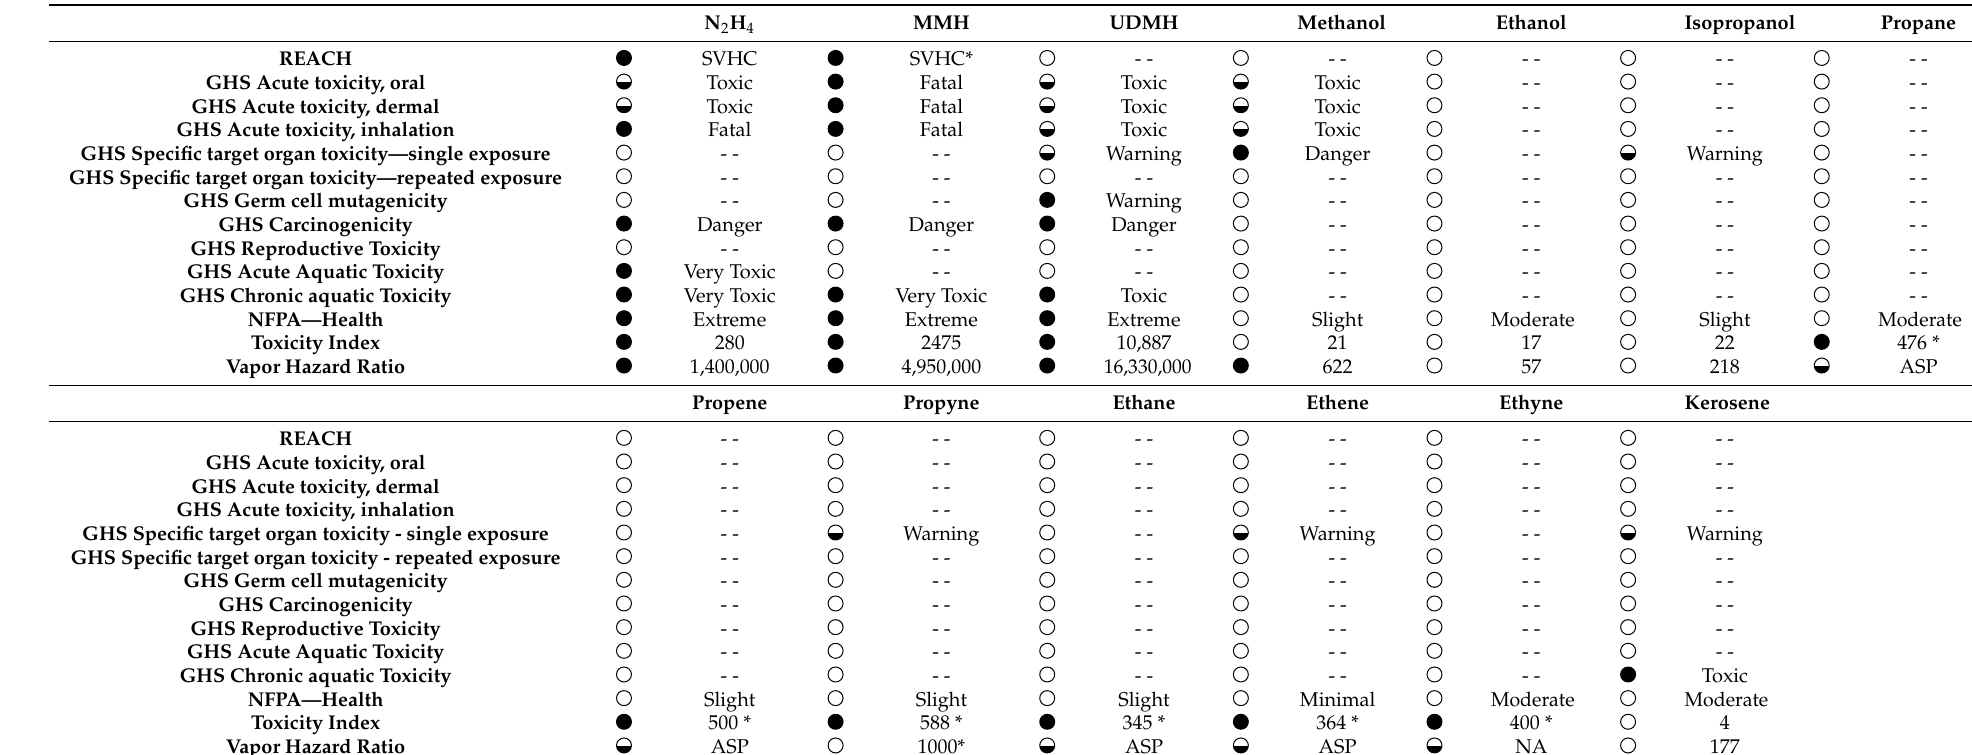
Table 11. Fuels toxicity